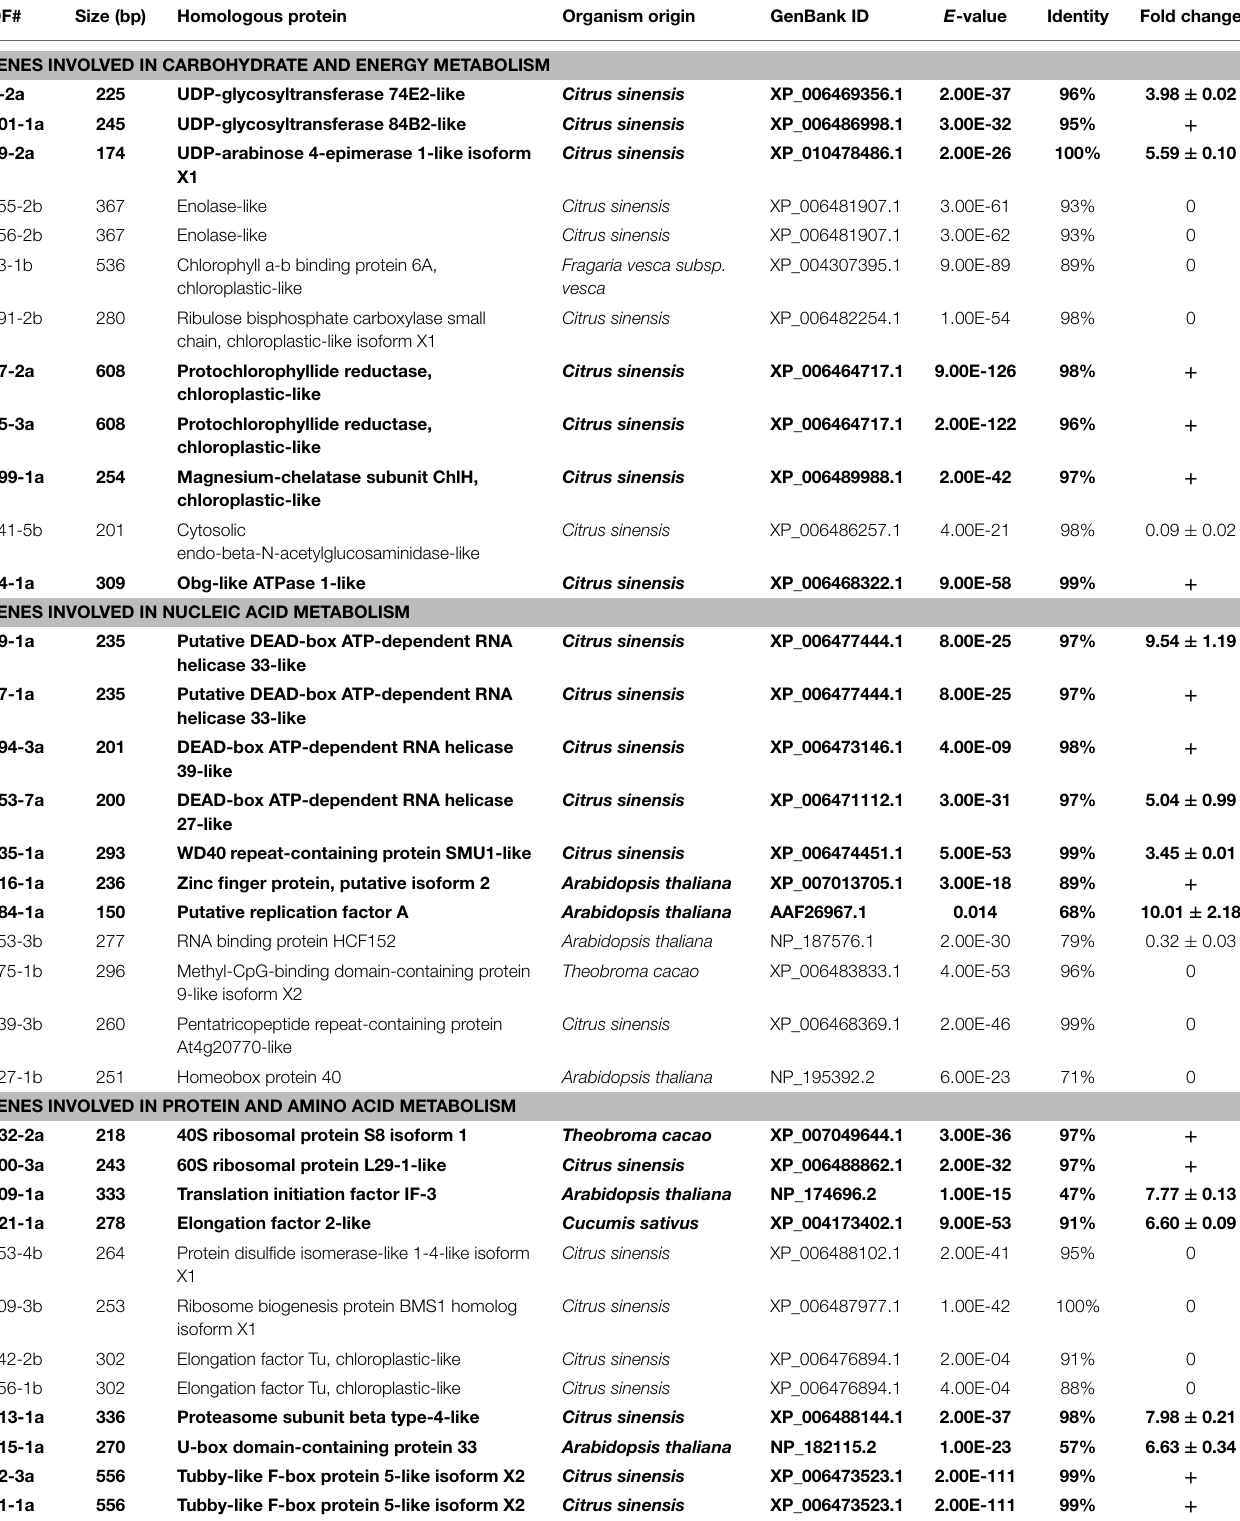
TABLE 2 | Homologies of differentially expressed cDNA-AFLP fragments with known gene sequences in database using BLASTN algorithm along with their expression patterns in B-deficient Citrus sinensis leaves. TDF# Size (bp) Homologous protein Organism origin GenBank ID E -value Identity Fold change GENES INVOLVED IN CARBOHYDRATE AND ENERGY